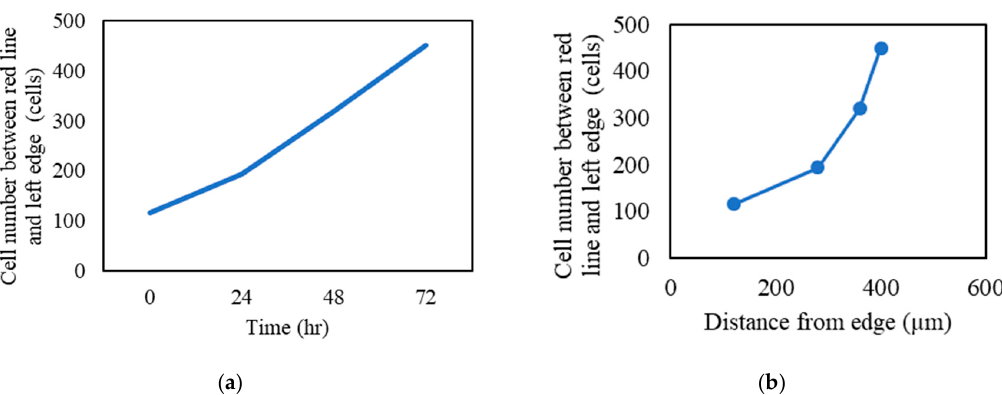
Figure 8. MSC recruitment test analysis: ( a ) cell number between the red line and left edge versus time and ( b ) cell number between the red line and left edge versus distance from the left edge.